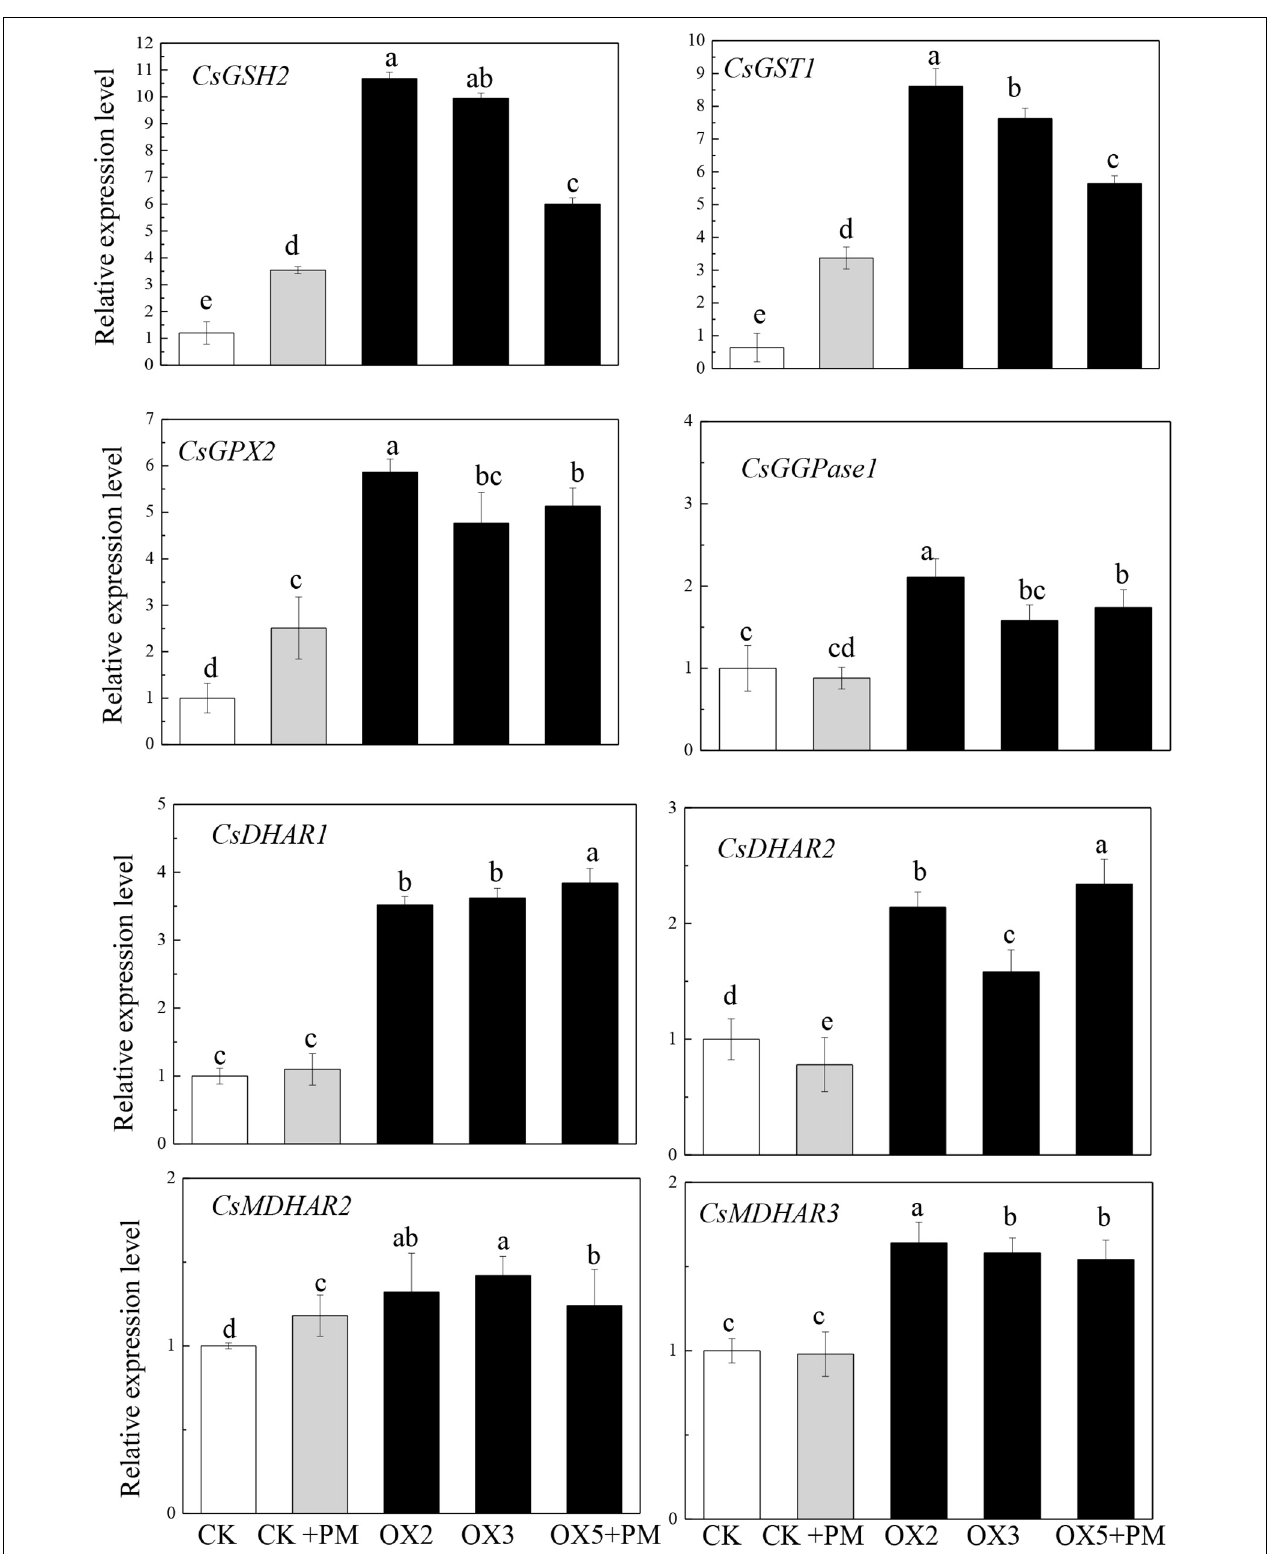
FIGURE 11 | Expression levels of key genes in in AsA-GSH system between the control (Col) and CsHMGB -overexpressing (OX) plants. CsEF1a was used as the reference gene. Different letters indicate significant differences between genotypes ( p < 0.05 by Tukey’s test). Error bars represent SE.